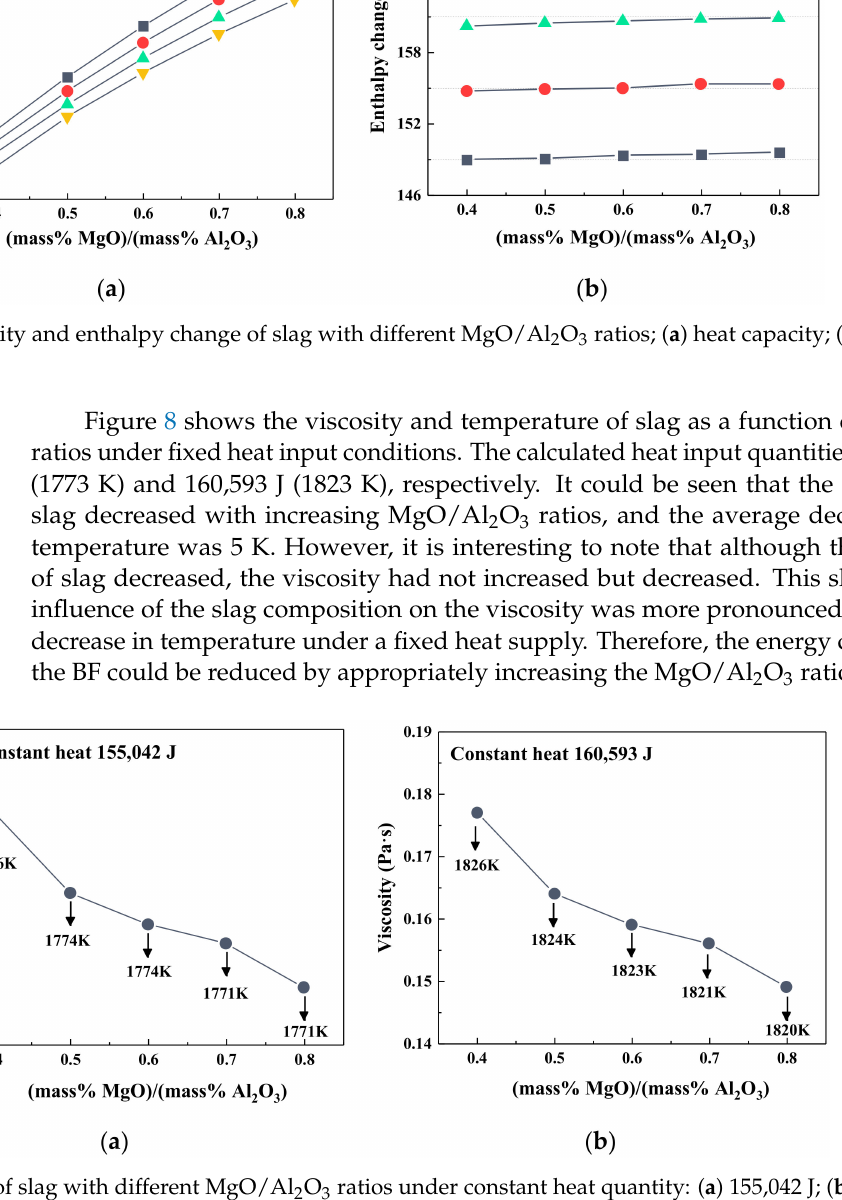
Figure 8. The viscosity of slag with different MgO/Al 2 O 3 ratios under constant heat quantity: ( a ) 155,042 J; ( b ) 160,593